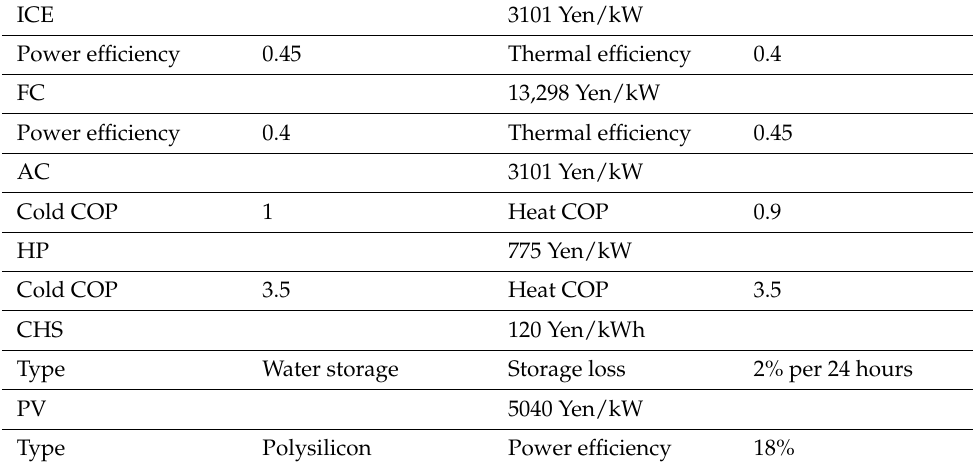
Table 4. Performance parameters and cost of energy equipment